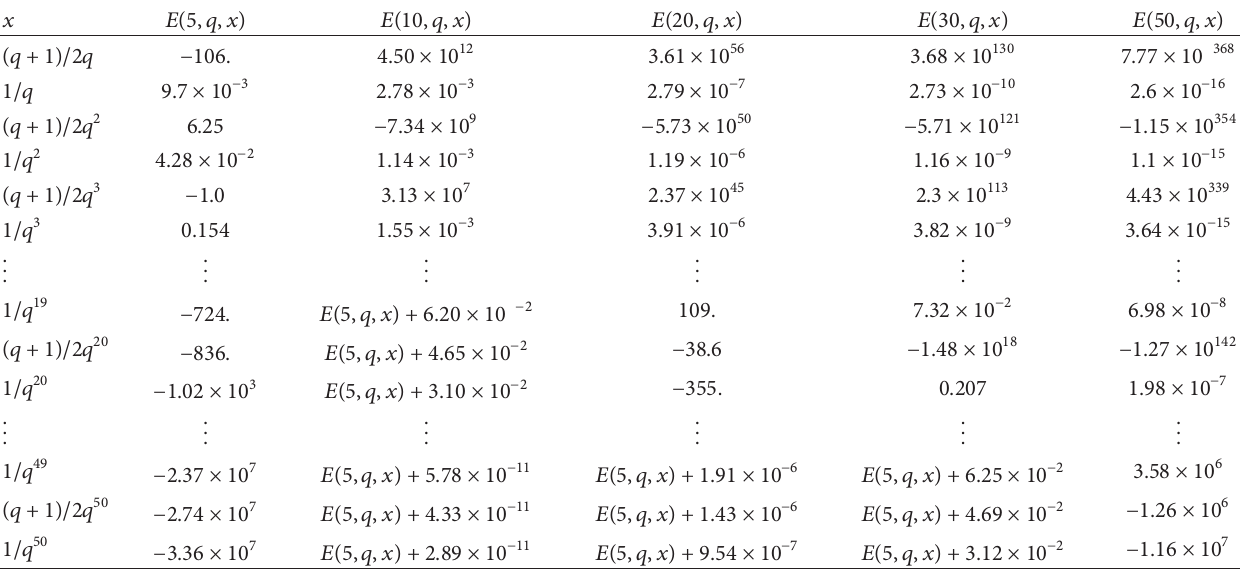
Table 1: The values of 𝐸(𝑛, 𝑞,𝑥) = 𝐵 𝑛,𝑞 (𝑔;𝑥) − 𝑔(𝑥) for 𝑞 = 2 at some points 𝑥 ∈ [0, 1] .